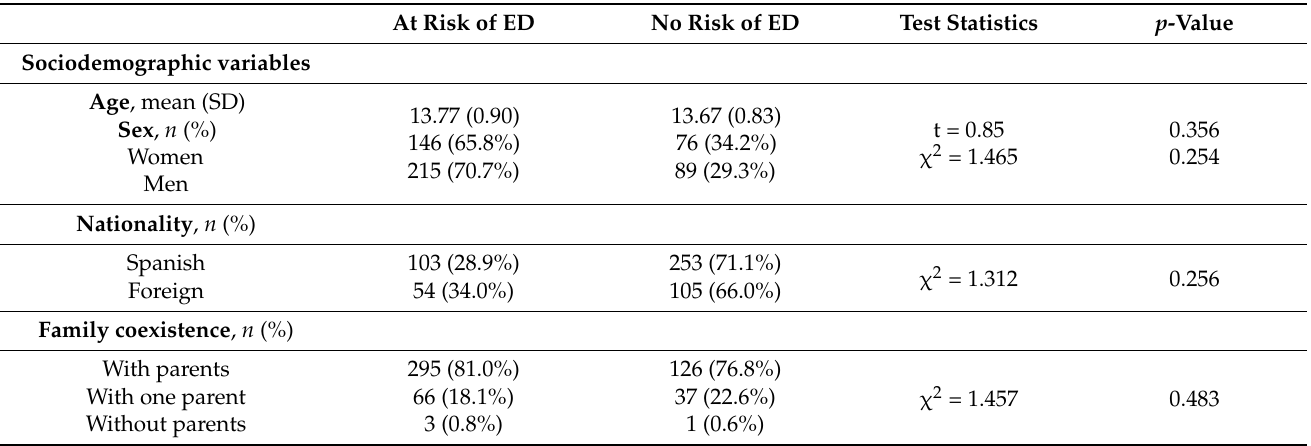
Table 2. Distribution of sociodemographic variables according to eating disorder risk. At Risk of ED No Risk of ED Test Statistics p